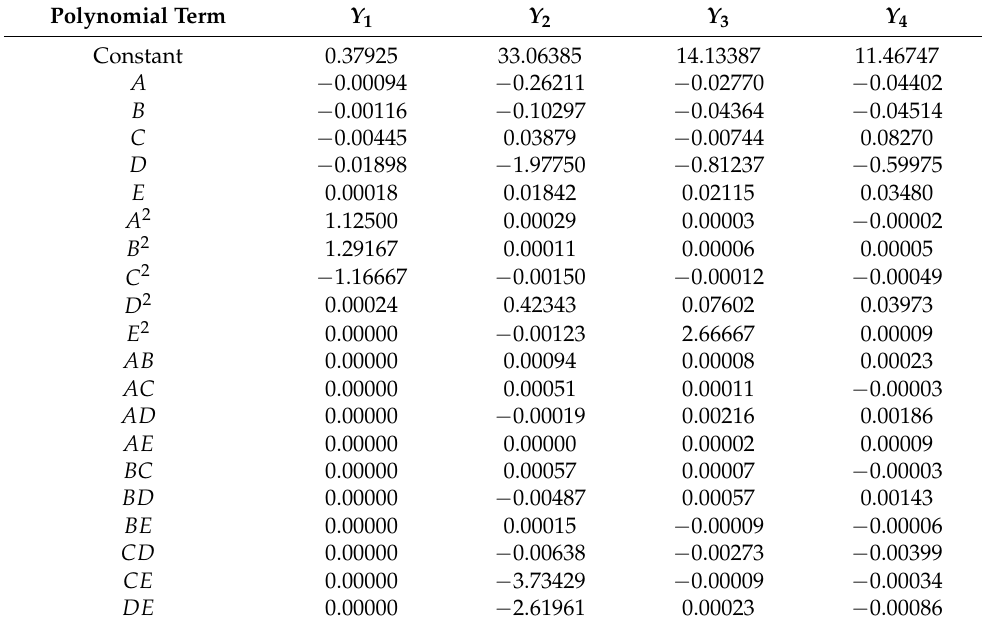
Table 7. RSM-Quadratic coefficient table.